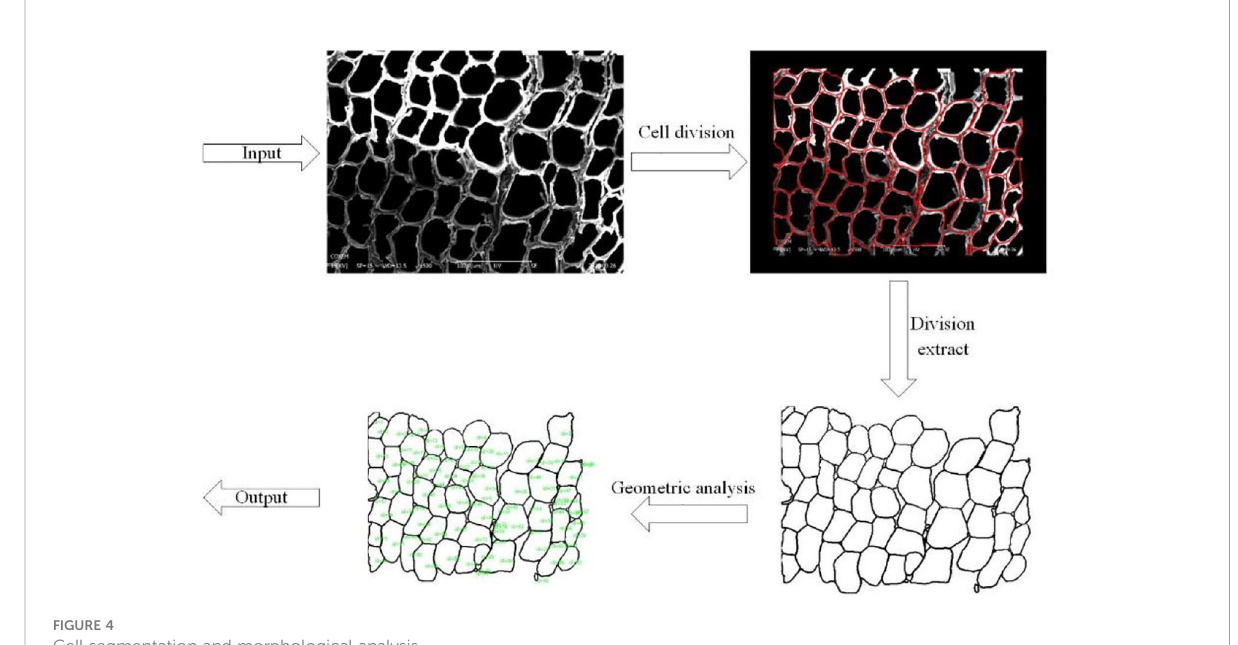
FIGURE 4 Cell segmentation and morphological analysis.